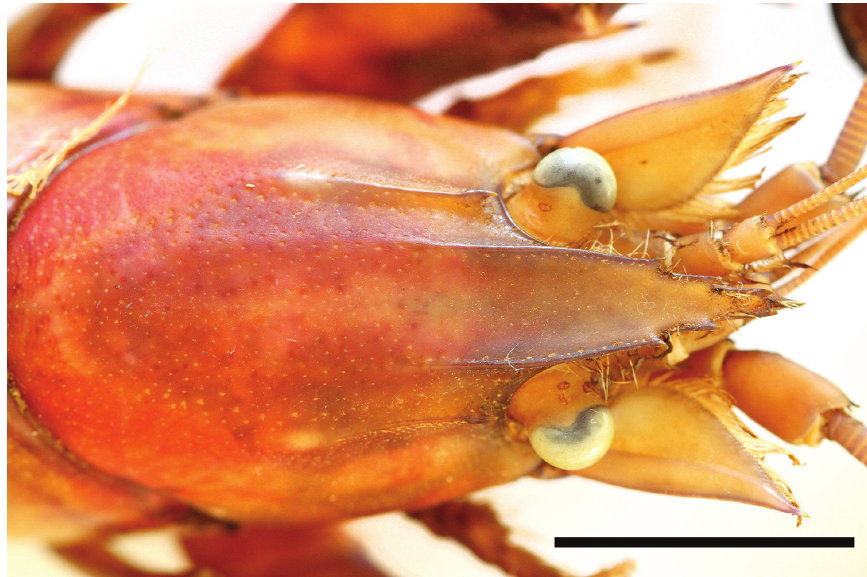
Figure 4. Cherax warsamsonicus sp. n. holotype male (MZB Cru 4529), dorsal view of cephalothorax. Scale bar: 10 mm.